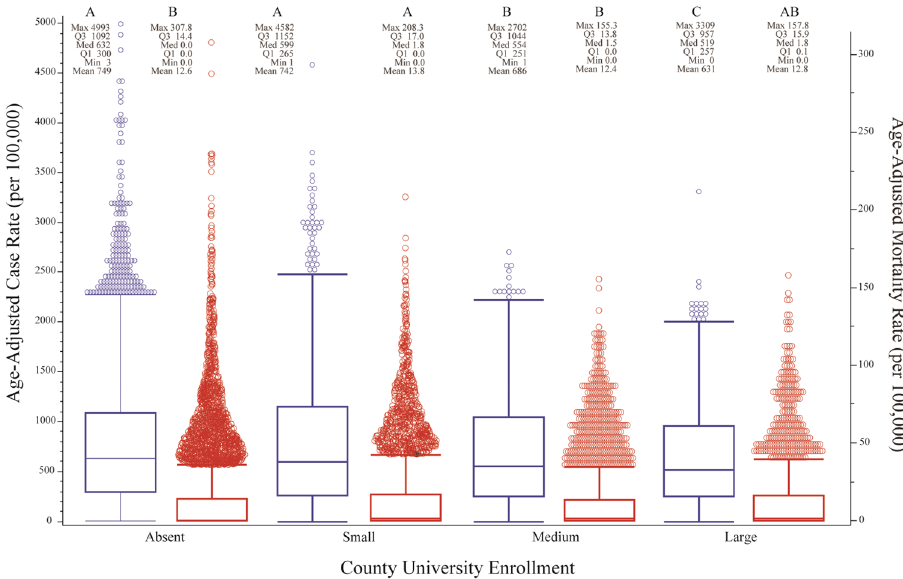
Figure 1. Box plot of laboratory-confirmed mean SARS-CoV-2 age-adjusted case (blue boxes) and mortality (red boxes) rates (per 100,000) by county university enrollment (none, small, medium, and large) among the United States population, from January 1, 2020 through March 30, 2021. Unique letters, arranged in descending order (highest mean value = A and so on), indicate statistically different groups (case and mortality rates, respectively; assessed by Student’s t-test, p value ≤ 0.05). Individual circles represent outlier counties.